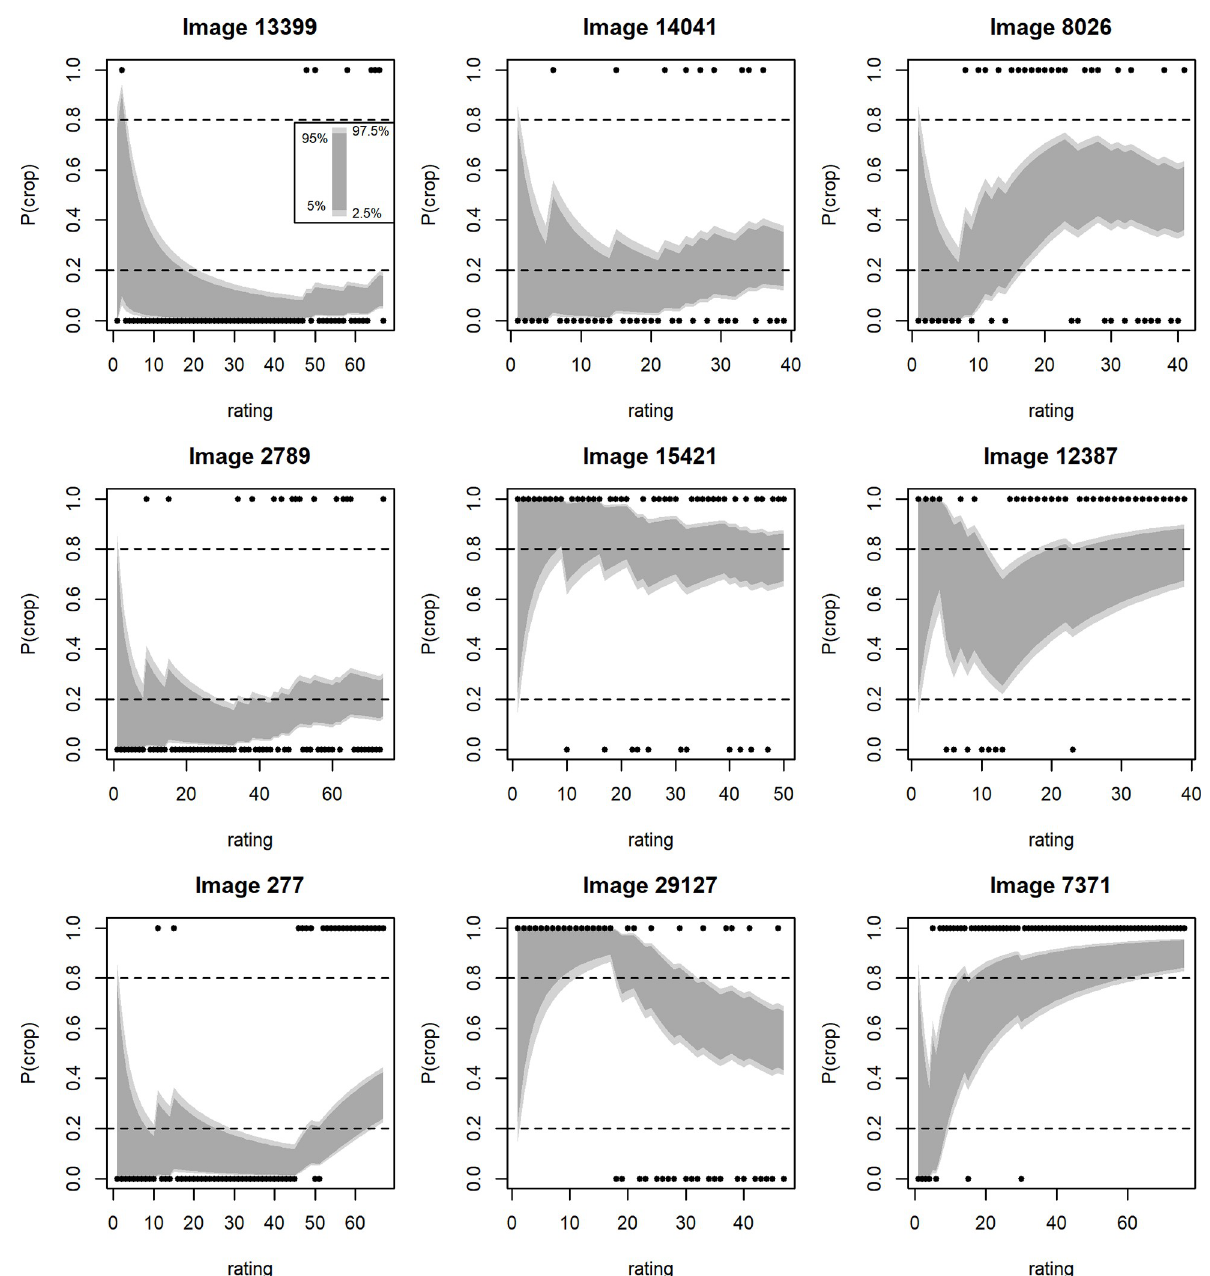
Fig 2. Some examples of the evolution of the posterior 95% credible interval of the estimated mean rate of classification of an image as cropland by volunteer raters. Each panel corresponds to a different image; the number of volunteer-contributed ratings differed among images (note the different x-axis scales). The inset in the first panel shows how different gray shades represent different quantile ranges of the estimated mean probability of classifying an image as cropland. The points along the upper and lower margins of panels represent actual ratings (0 = not cropland, 1 = cropland). The horizontal dashed lines represent the level of certainty about classifications ( < 20% disagreement) considered in this study. Most images show patterns similar to those in the top row of this